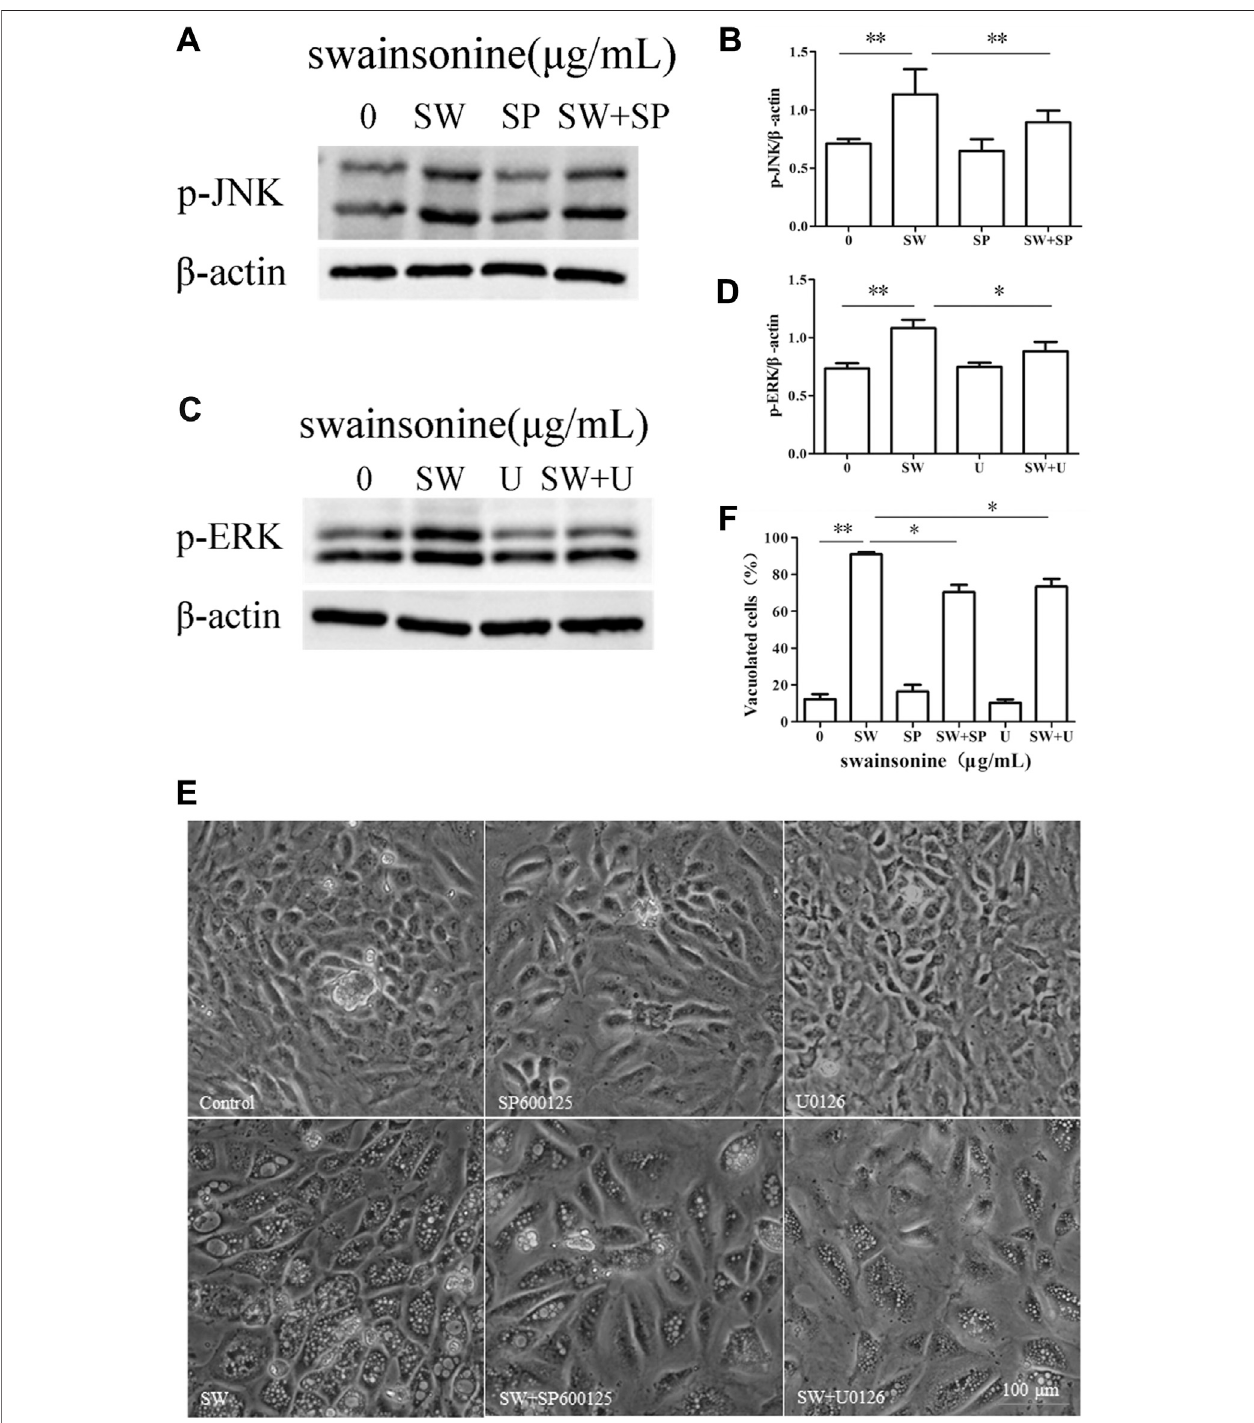
FIGURE 10 | Effects of MAPK pathway inhibitors on SW-induced cytoplasmic vacuolization. RTECs were pretreated with SP600125 or U0126 at the indicated concentrations for 4 h and further treated with 400 μ g/ml SW for 24 h (A – D) Western blotting was used to analyze the p -JNK and p -ERK protein level changes. Three independent experiments wereperformed. * p < 0.05,** p < 0.01 (E,F) Inverted microscopicimagesofRTECstreatedwithSW(400 μ g/ml)inthepresence ofSP600125 or U0126. Morphometric analysis of vacuoles was performed with three different areas and the percentage of SW-induced vacuolated cells was calculated.